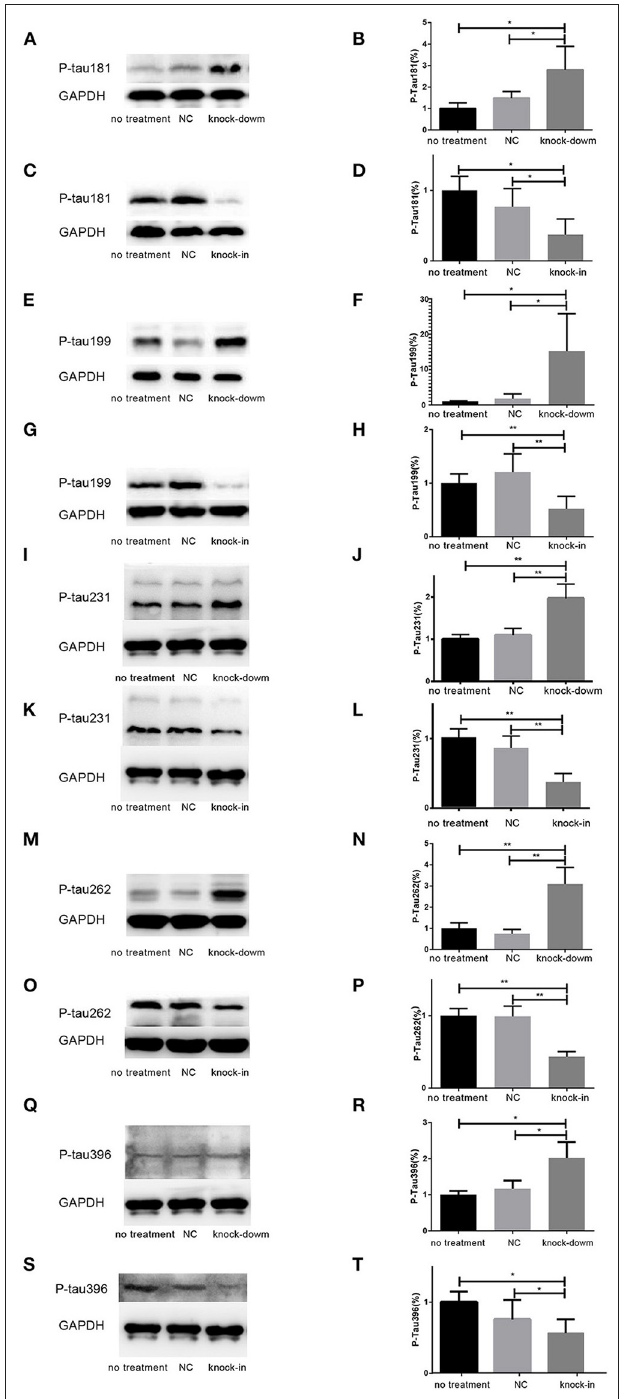
FIGURE 2 | DHCR24 knock-down induced hyperphosphorylation of Tau protein at Thr181, Ser199, Thr231, Ser262, and ser396 in SH-SY5Y cells. (A,B,E,F,I,J,M,N,Q,R) Representative western blots of phosphorylated tau at residues Thr181, Ser199, Thr231, Ser262, and Ser396 from DHCR24 knock-down SH-SY5Y cells. (C,D,G,H,K,L,O,P,S,T) Representative western blots of phosphorylated tau at residues Thr181, Ser199, Thr231, Ser262, and Ser396 from DHCR24 knock-in SH-SY5Y cells. All the data are presented as mean ± SD of at least three individual experiments ( n = 3).* P < 0.05, ** P < 0.01; vs. the no treatment and NC group ( Figures 2I , Q , 3E share one loading